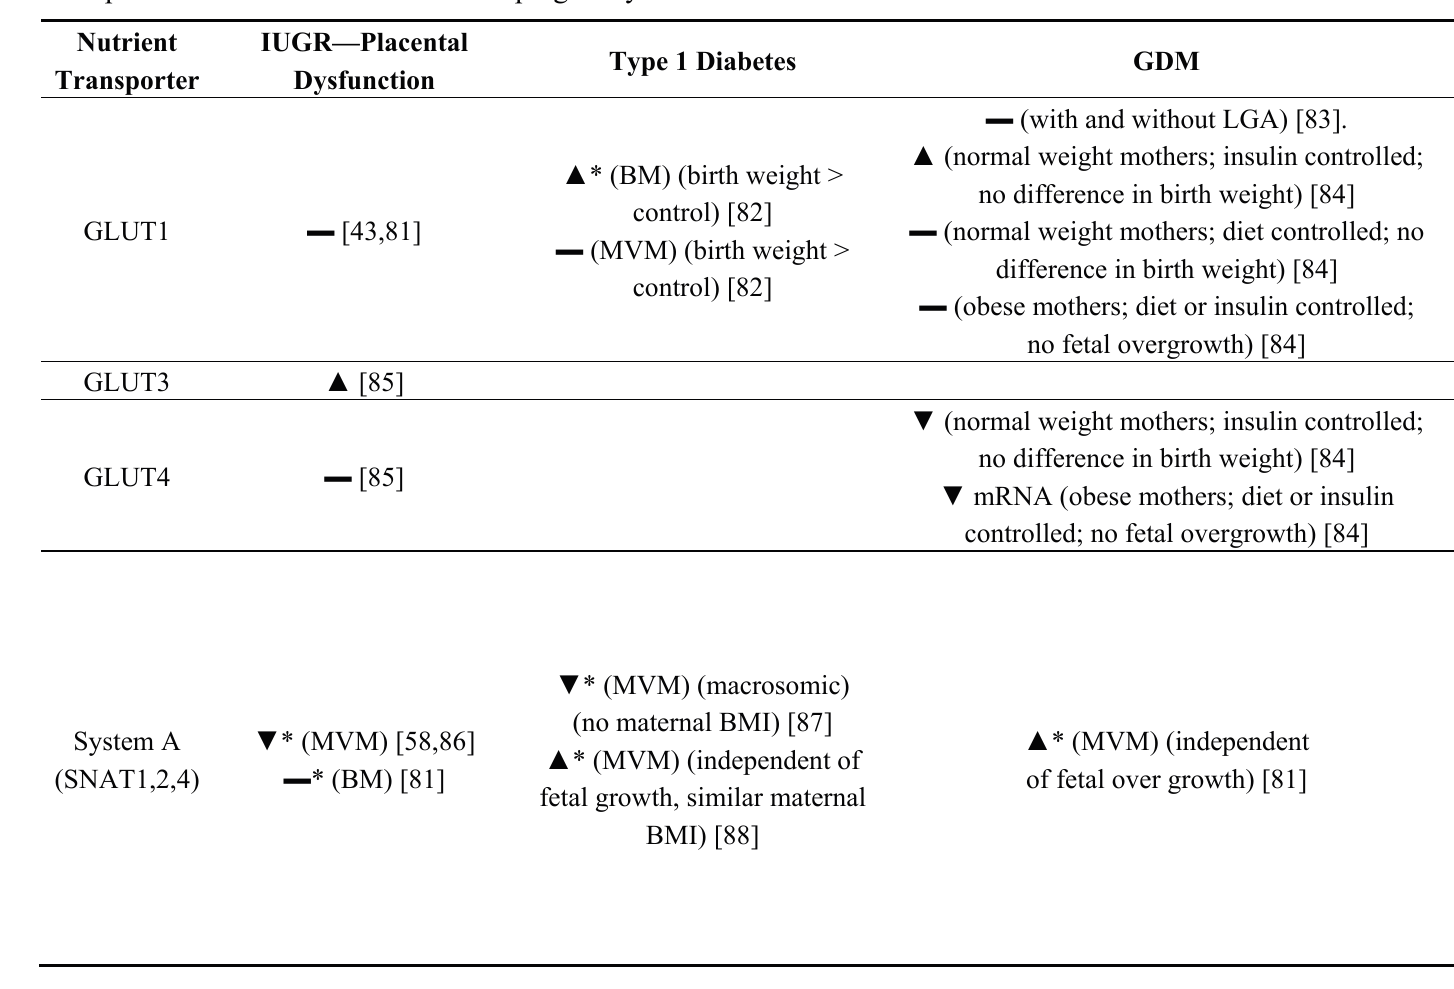
Table 1. Changes in expression level (protein or mRNA) and activity of the glucose, amino acid and fatty acid transporters in the human placenta associated with different pregnancy conditions 1,2